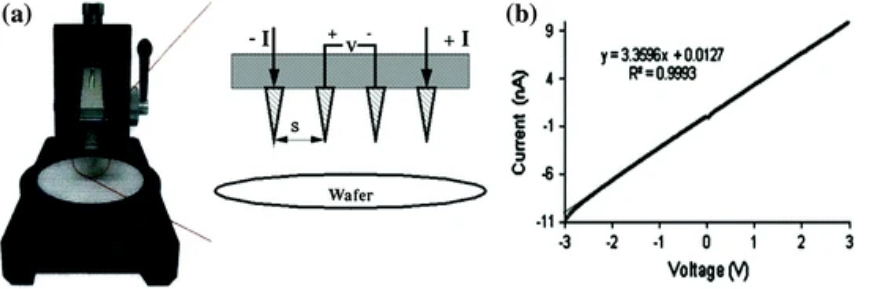
Figure 21. ( a ) Four-point probe set-up and ( b ) I–V curve at a voltage in range from − 3 to +3 V for electrospun PLLA/PANI nanofibers. Reproduced from [155, 156] with the permission of Elsevier. Agend et al. utilized scanning electron microscope images of carbonized polyacrylo-